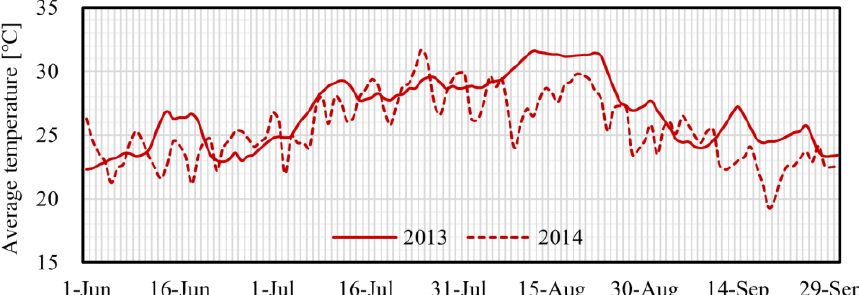
Figure 1. Variation in the daily average outdoor air temperature from June to September in